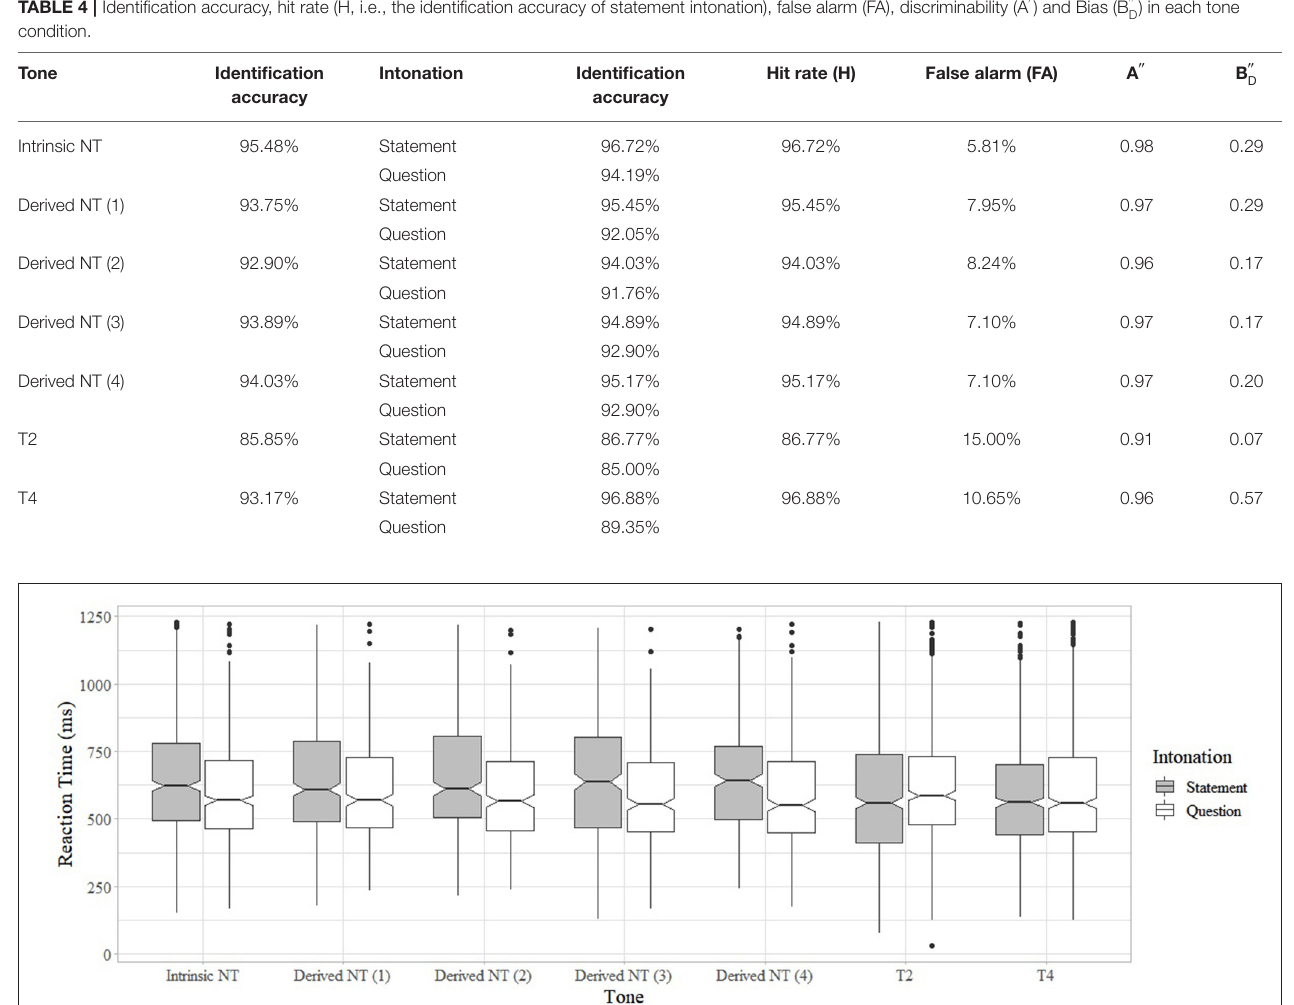
FIGURE 3 | Reaction time by tone and intonation (Numbers in brackets indicate the phonological tones of Derived